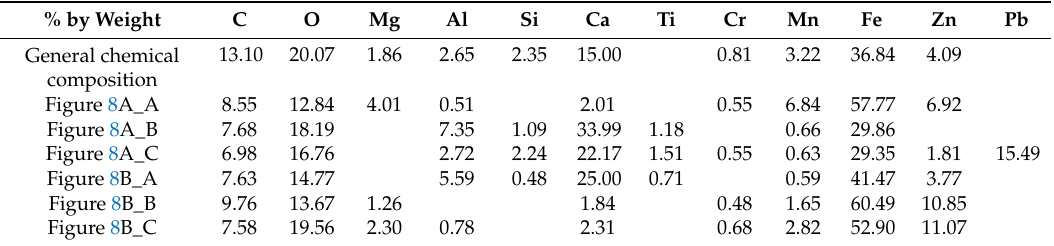
Table 9. SEM-EDS analysis of as-received coarse combustion chamber dusts.